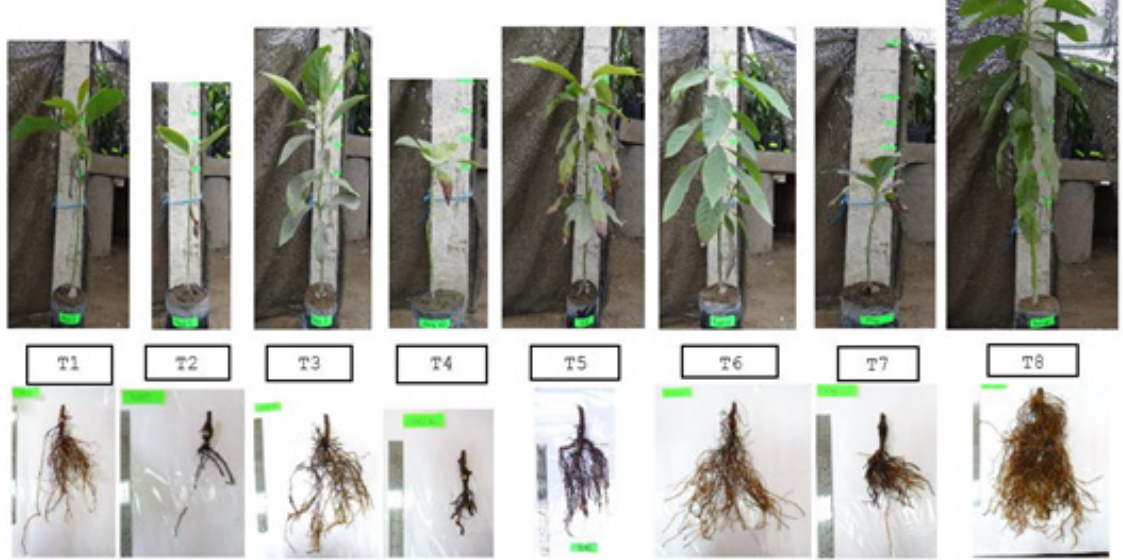
Fig. 3. Photograph of foliar and root area of avocado cv. ‘Zutano’, six months after inoculated with soil and root isolates of Pseudomonas sp. and P. cinnamomi , under greenhouse